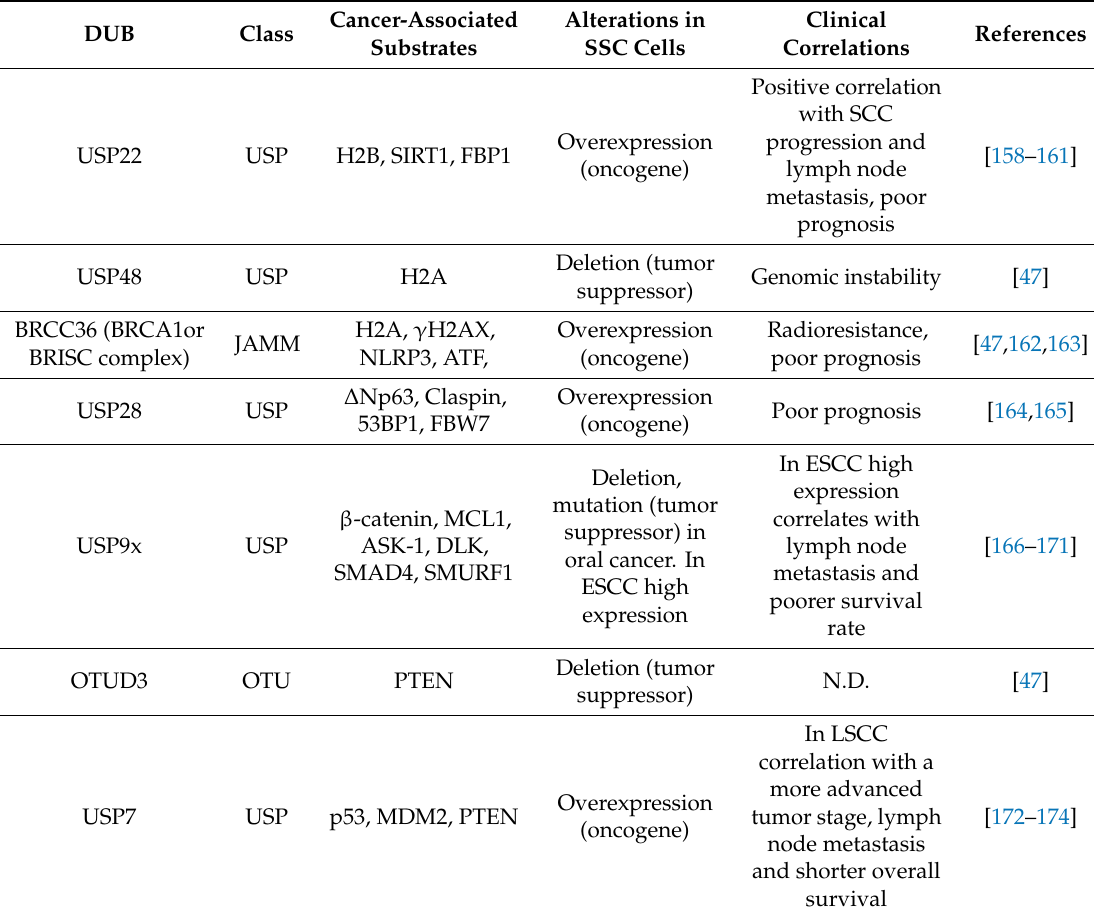
Table 2. Deregulation of the DUBs in